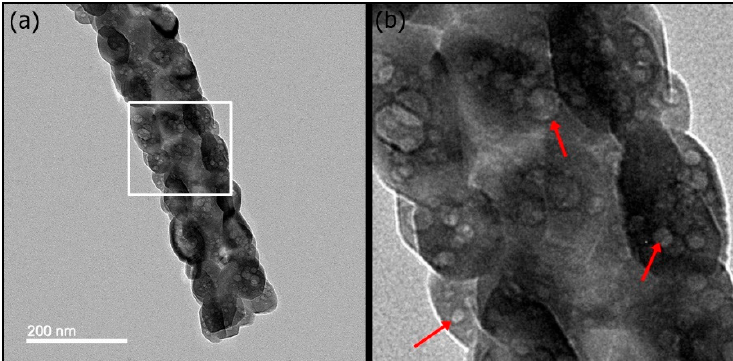
Figure 2. Transmission electron microscopy (TEM) micrographs of the 3mSrHANFs. The image in ( b ) showed an enlarged view of the white square in ( a ). The red arrows in ( a ) indicate the nonordered orientation of the mesopores within the nanocrystals.